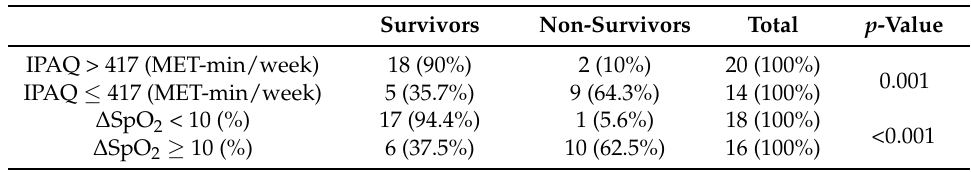
Table 3. Physical activity and exertional desaturation characteristics in survivor and non-survivor idiopathic pulmonary fibrosis patients.